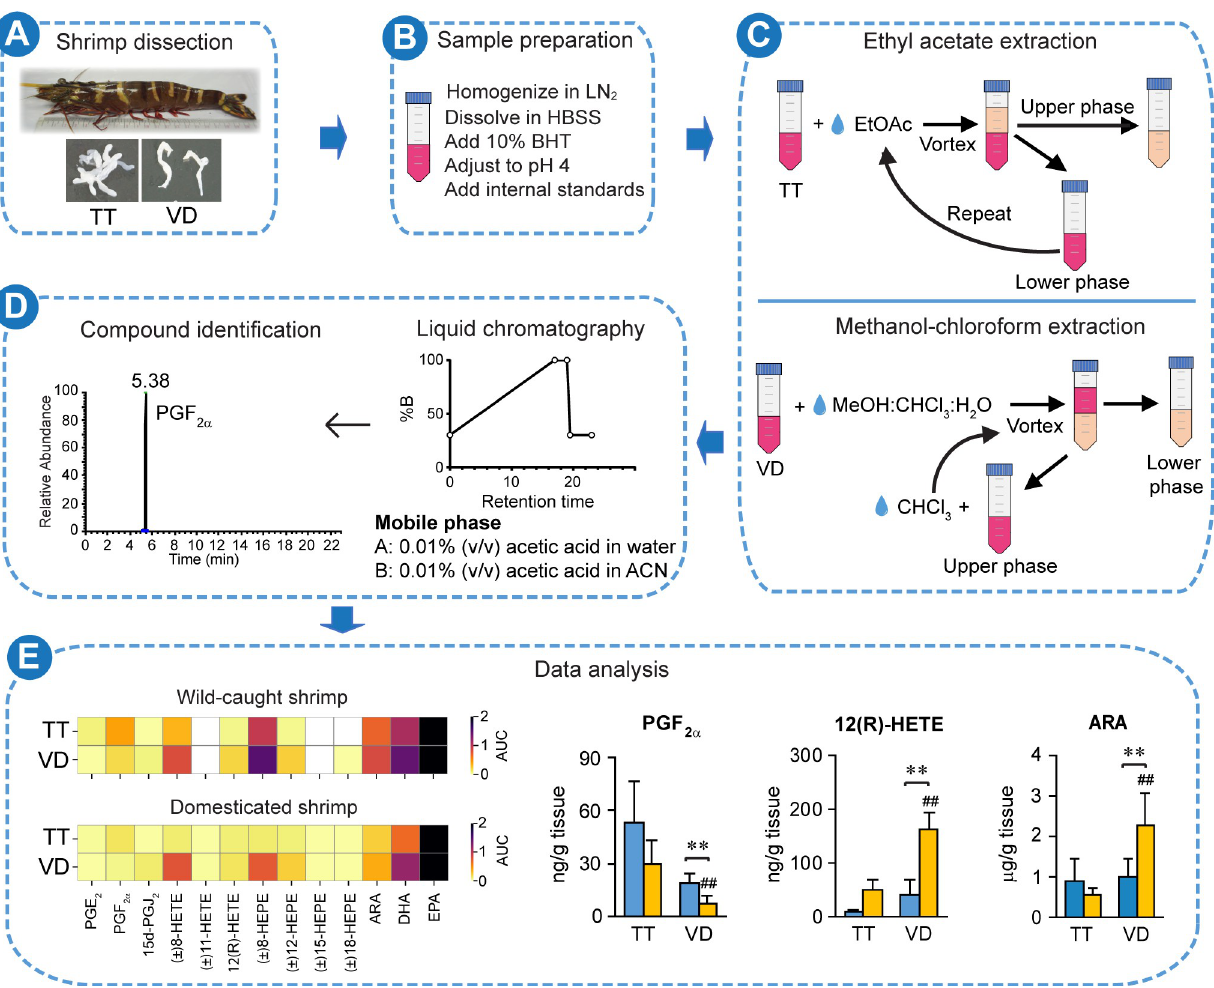
Fig 2. Overview of liquid-liquid extraction and UHPLC-HRMS/MS analysis of eicosanoids and PUFAs in the P . monodon male reproductive tract. (A) Male P . monodon broodstocks were dissected to obtain testes (TT) and vas deferens (VD). (B) Sample preparation included tissue homogenization, pH adjustment, addition of antioxidant (10% BHT), and addition of internal standards. (C) Testis homogenates were subjected to ethyl acetate extraction (upper panel) whereas vas deferens homogenates were subjected to methanol-chloroform extraction (lower panel). (D) Tissue extracts were analyzed using the UHPLC system. Eicosanoids and PUFAs were then identified using HRMS/MS. (E) Metabolite quantification and data analysis were performed to determine levels of eicosanoids and PUFAs in each organ. LN 2 and ACN were abbreviated for liquid nitrogen and acetonitrile, respectively.